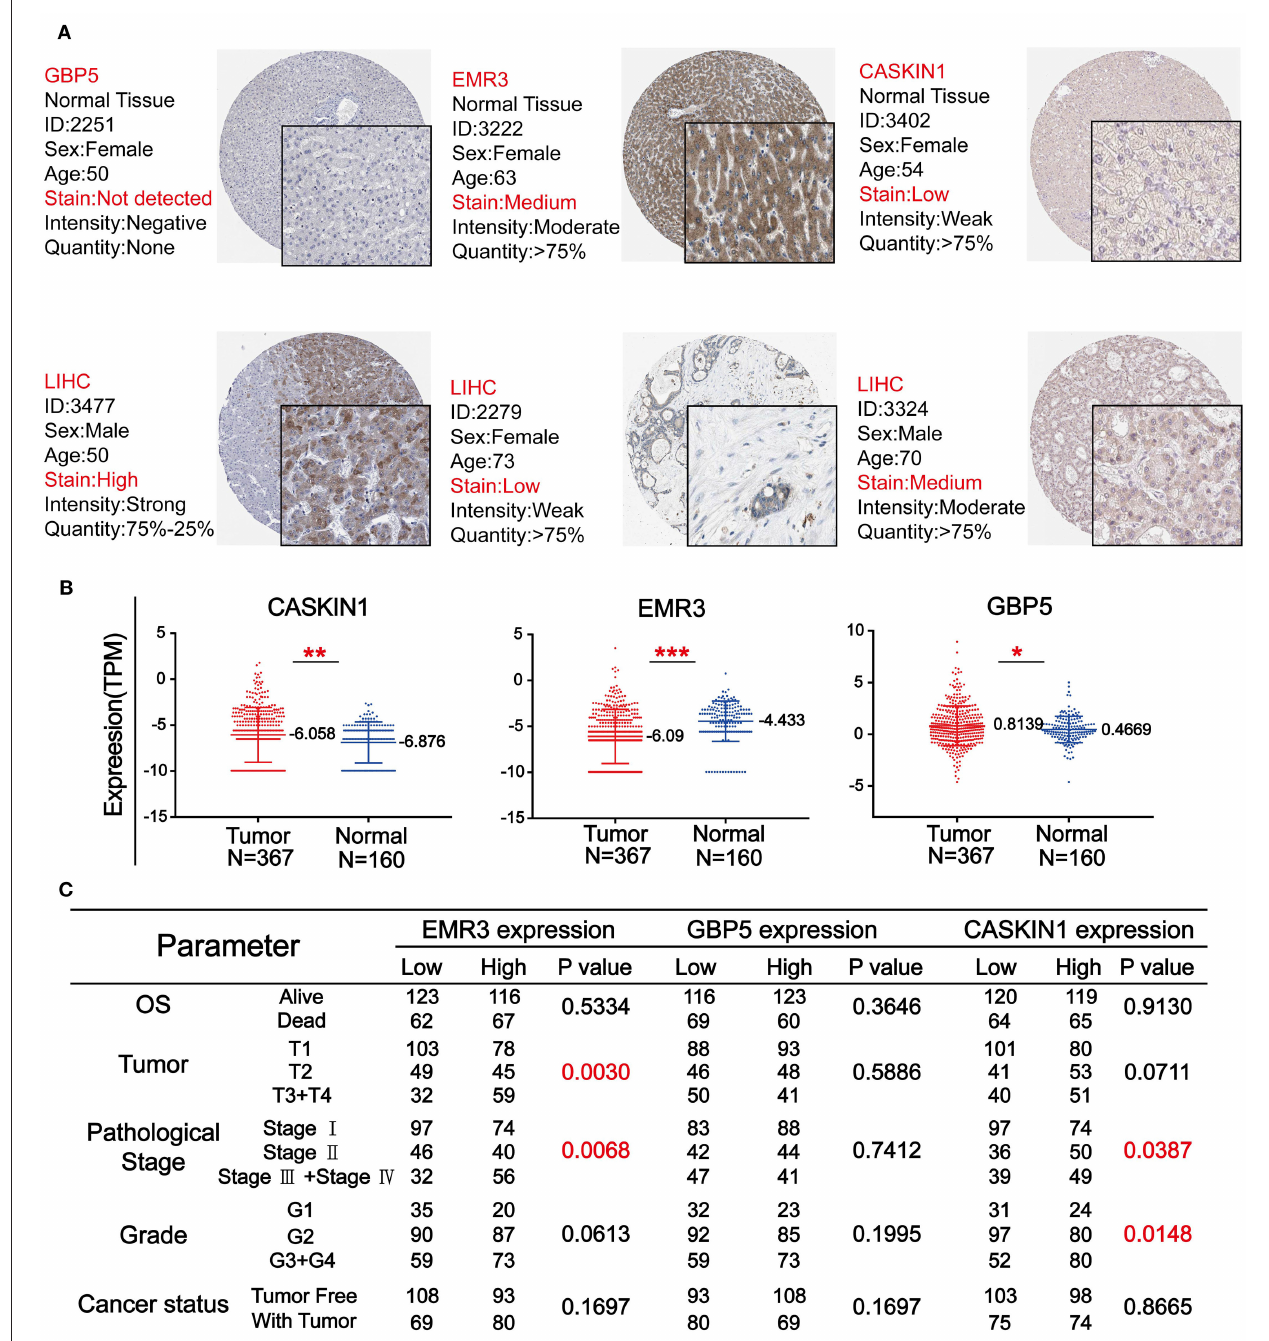
FIGURE 5 | The expression level of three genes in HCC. (A) The immunohistochemistry (IHC) results from the Human Protein Atlas (HPA) was used to detect the protein level of three genes in normal and tumor tissues. (B) Comparison of the expression levels of CASKIN1, EMR3, and GBP5 genes in HCC tissues and adjacent normal tissues form the Cancer Genome Atlas (TCGA) database. The values of * p < 0.5, ** p < 0.01, and *** p < 0.001 between the two groups. (C) Chi-square test of the clinical parameters according to the median of the expressions of the three genes.